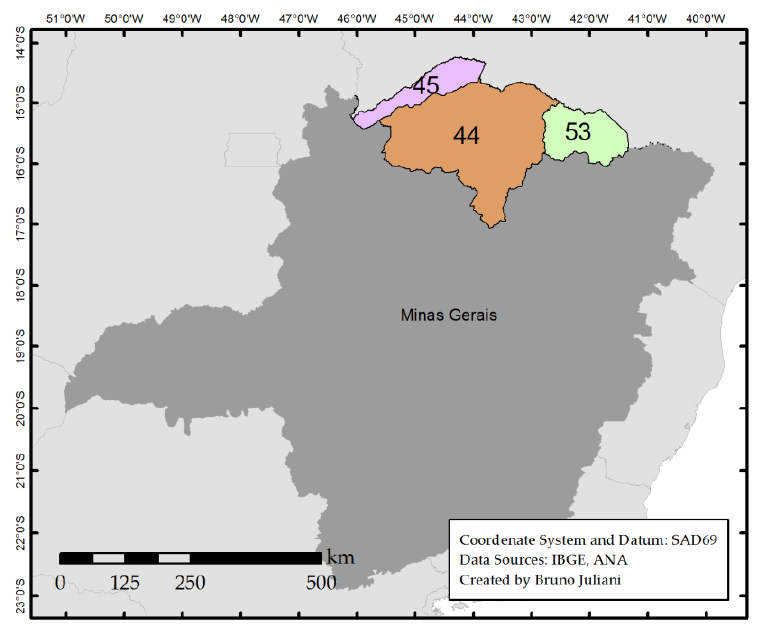
Figure 1. Sub-catchments influenced by the semi-arid climate in Minas Gerais.